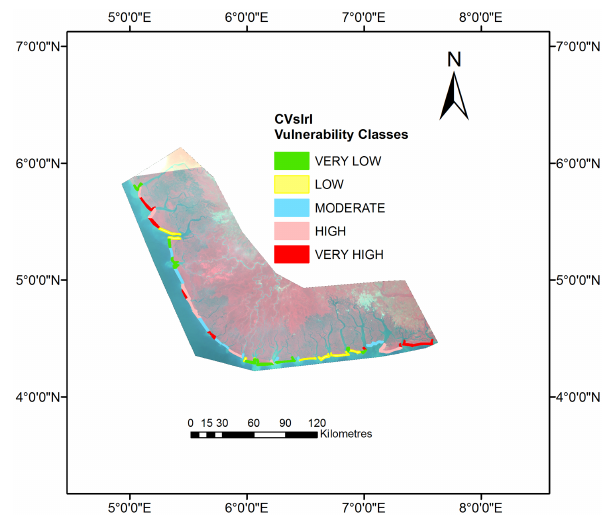
Figure 6. Niger Delta coast vulnerability